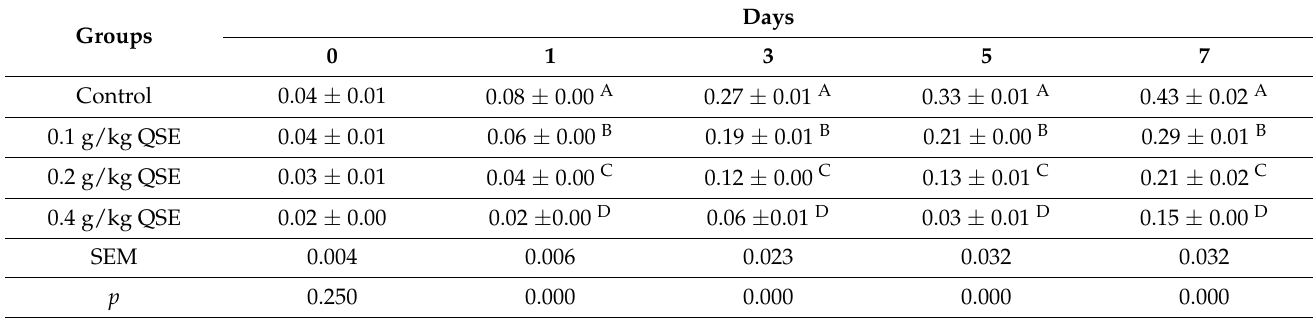
Table 10. Thiobarbituric acid (TBA) value of breast meat (mg MDA/kg).